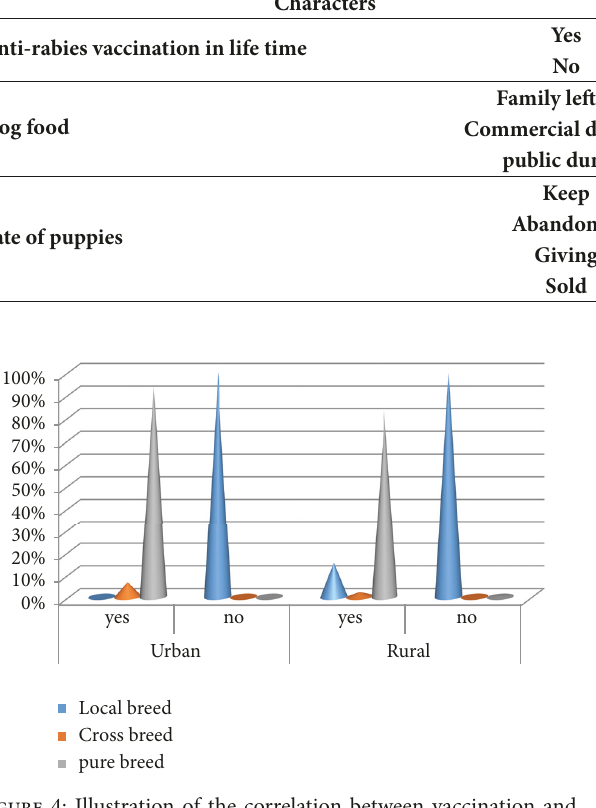
Figure 4: Illustration of the correlation between vaccination and breed.